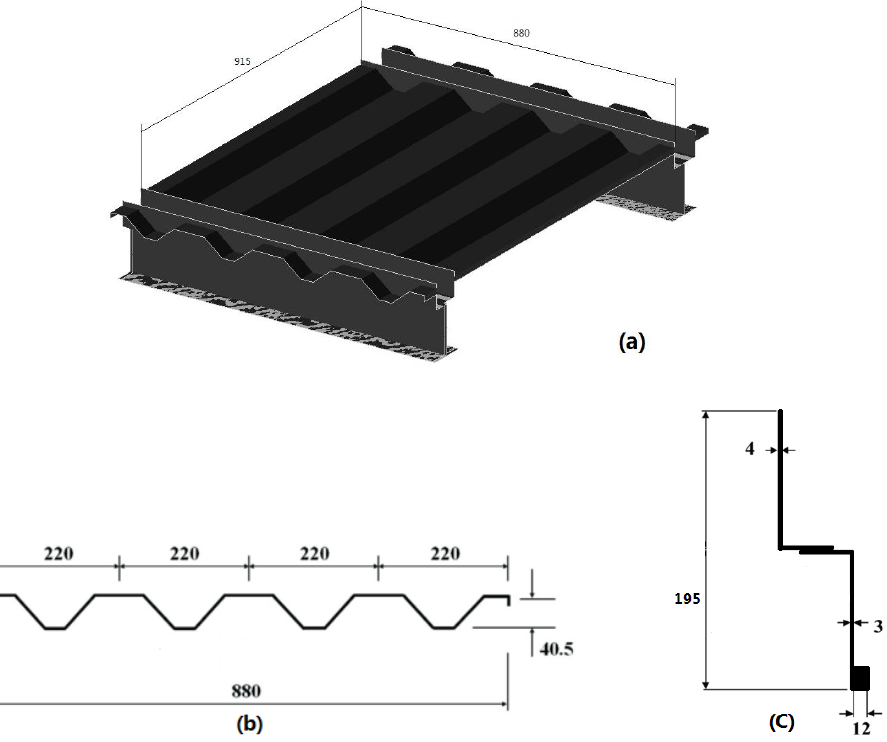
Figure 2. CBW ( a ) model ( b ) dimensions of corrugated panel ( c ) dimensions of connection.